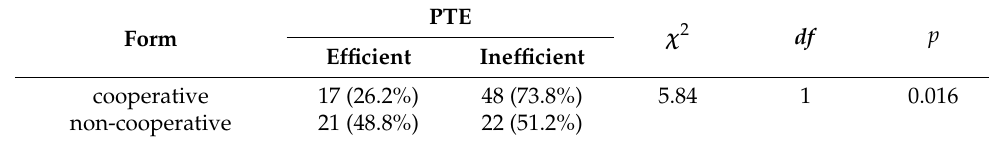
Table 6. Sample structure according to PTE scores (authors’ calculations based on [77]). PTE χ 2 df p Form Efficient Inefficient cooperative 17 (26.2%) 48 (73.8%) 5.84 1 0.016 non-cooperative 21 (48.8%) 22